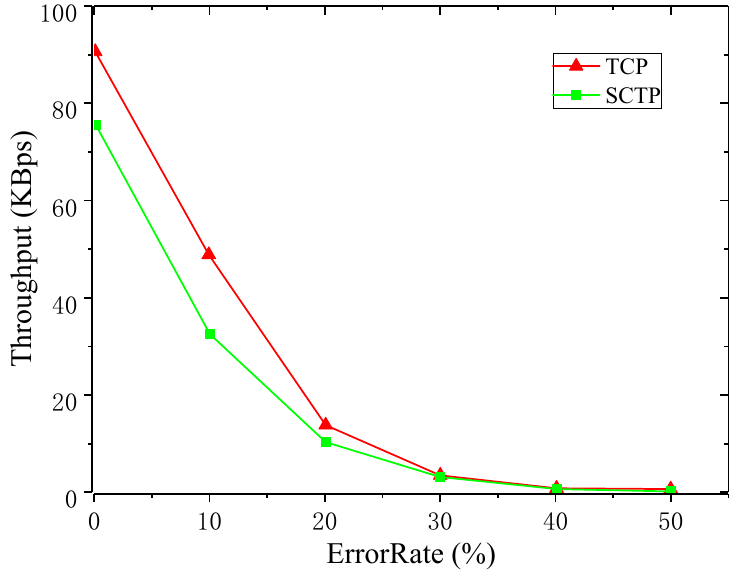
Figure 2. Comparison of average throughput between SCTP and TCP.